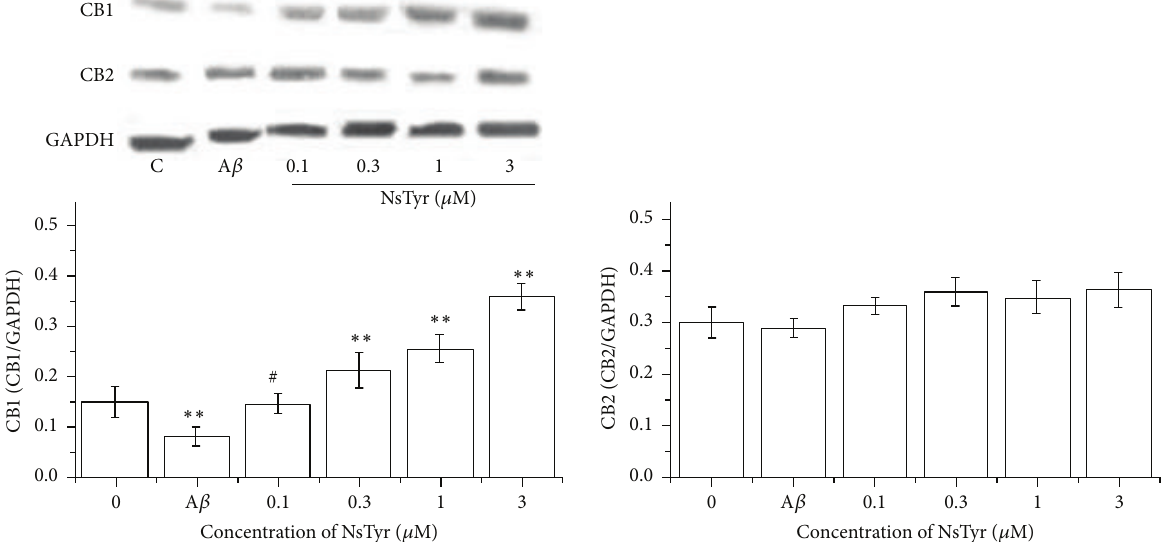
Figure4:TheexpressionofCB1andCB2receptorsinNSPCs.TheNSPCsweretreatedwith(1)none,(2)1 𝜇 MA 𝛽 1